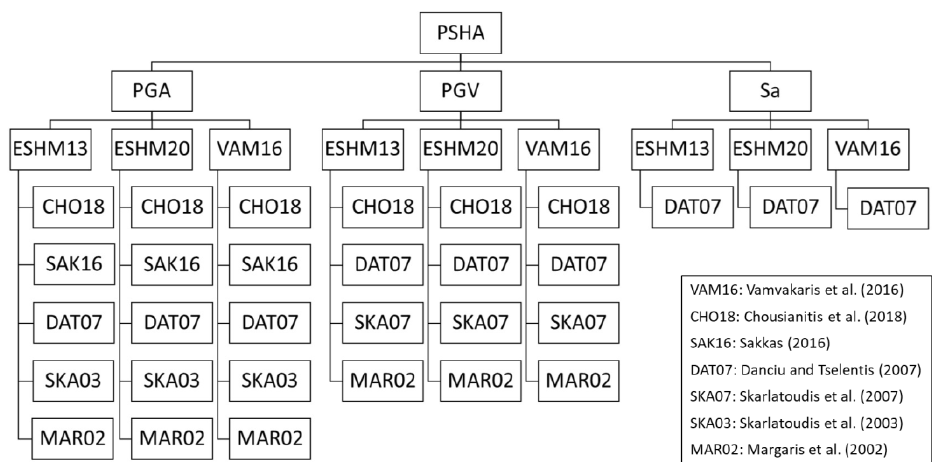
Figure 2. The logic tree constructed to calculate PGA, PGV, and S a . All branches have the same weight- ing coefficient. Results were generated for return periods of 475 and 950 years for both PGA and PGV and 475 years for S a . Abbreviations: VAM16: Vamvakaris et al. [65], CHO18: Chousianitis et al. [78], SAK16: Sakkas [77], DAT07: Danciu and Tselentis [76], SKA07: Skarlatoudis et al. [75], SKA03: Skarlatoudis et al. [74], MAR02: Margaris et al. [73].